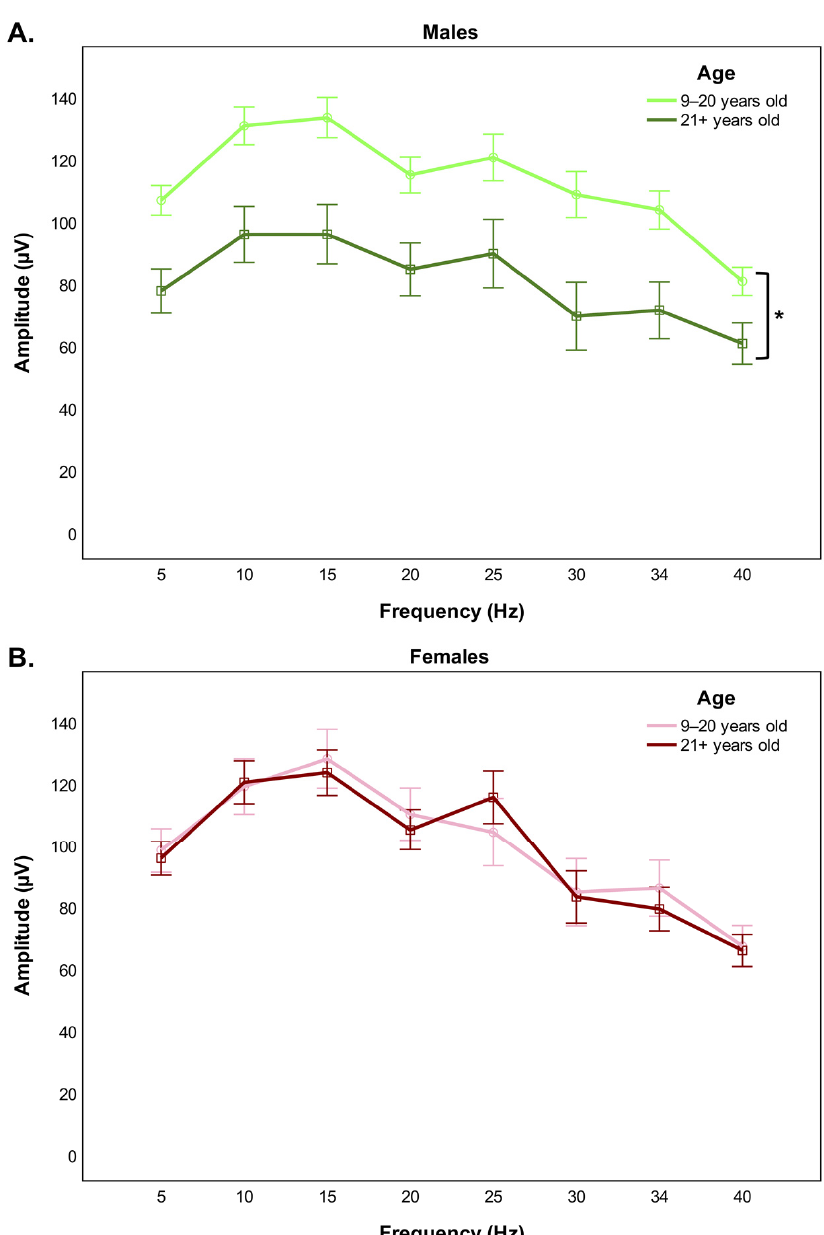
Figure 3. Sex-specific differences in the amplitude of the flicker ERG response with aging. The amplitude of the retinal response elicited at eight different flash frequencies is reduced in old males compared to young males ( A ), but it remains unaltered in old females compared to young females ( B ). Error bars represent standard errors of the mean (SEM). * p < 0.05